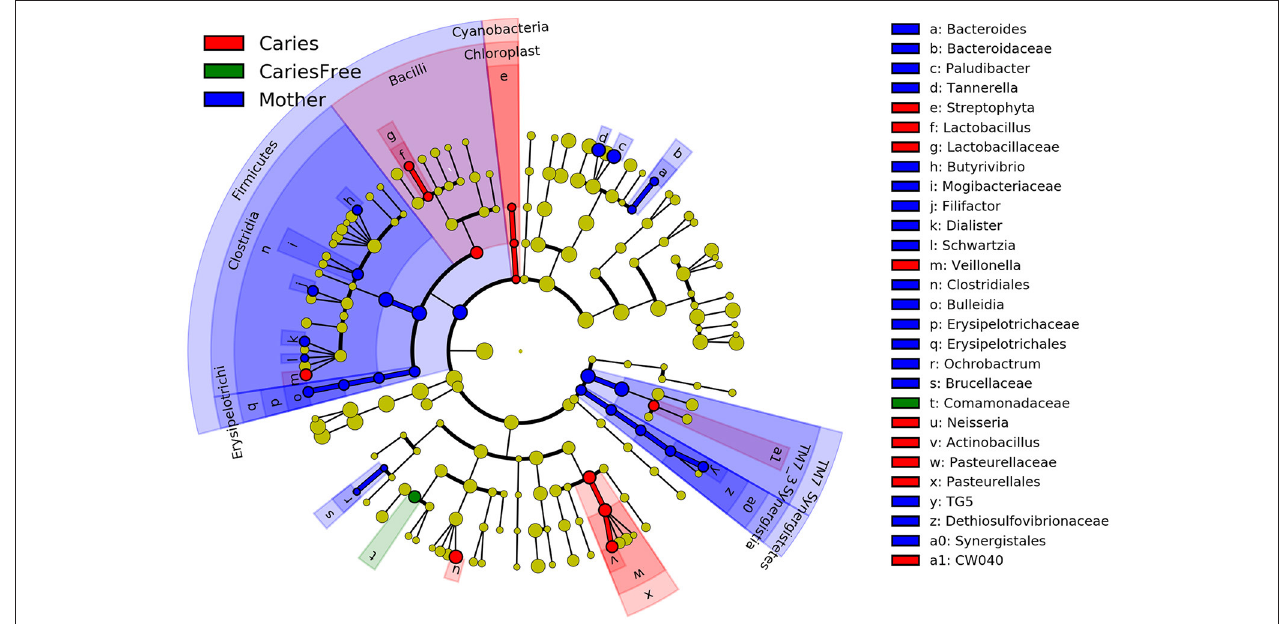
FIGURE 6 | LEfSe cladogram identified the most differentially abundant taxons in three groups. Taxonomic cladogram obtained from LEfSe analysis of 16S amplicon sequences (relative abundance ≥ 0.5%). (Blue) mother group-enriched taxa; (Red) taxa enriched in caries group; (Green) showed the enriched taxa in caries-free group. The brightness of each dot is proportional to its effect